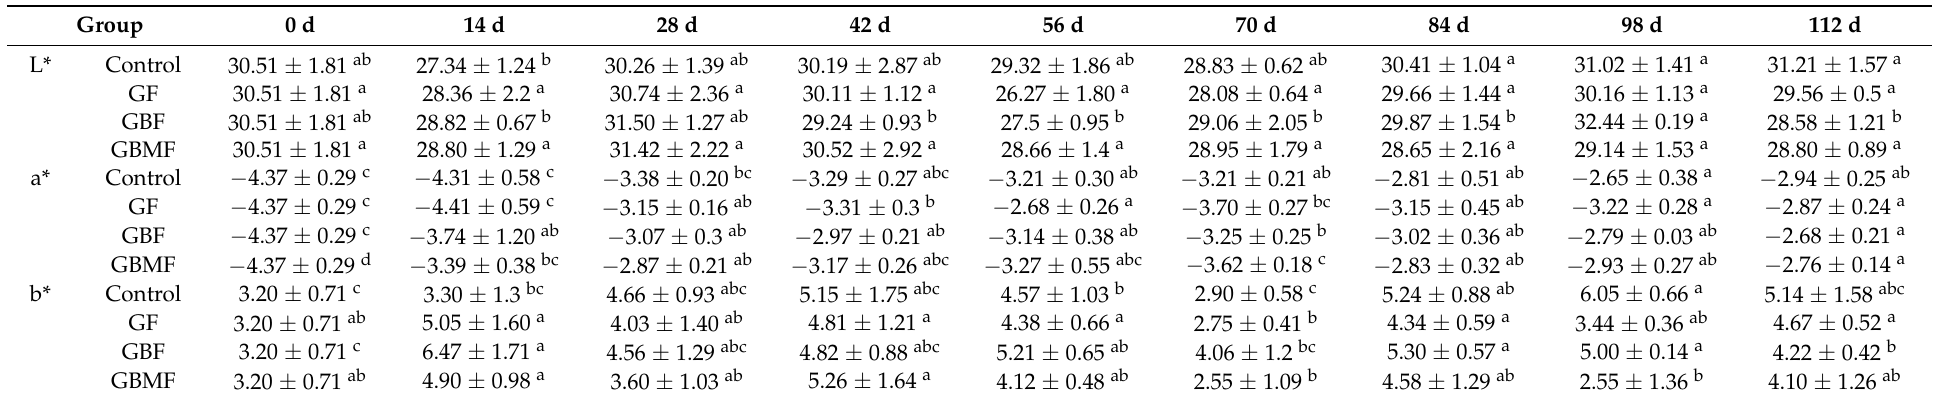
Different superscript letters in the same row indicate significant difference ( p < 0.05). Table 5. Changes in the color of the preserved egg yolk coated with different